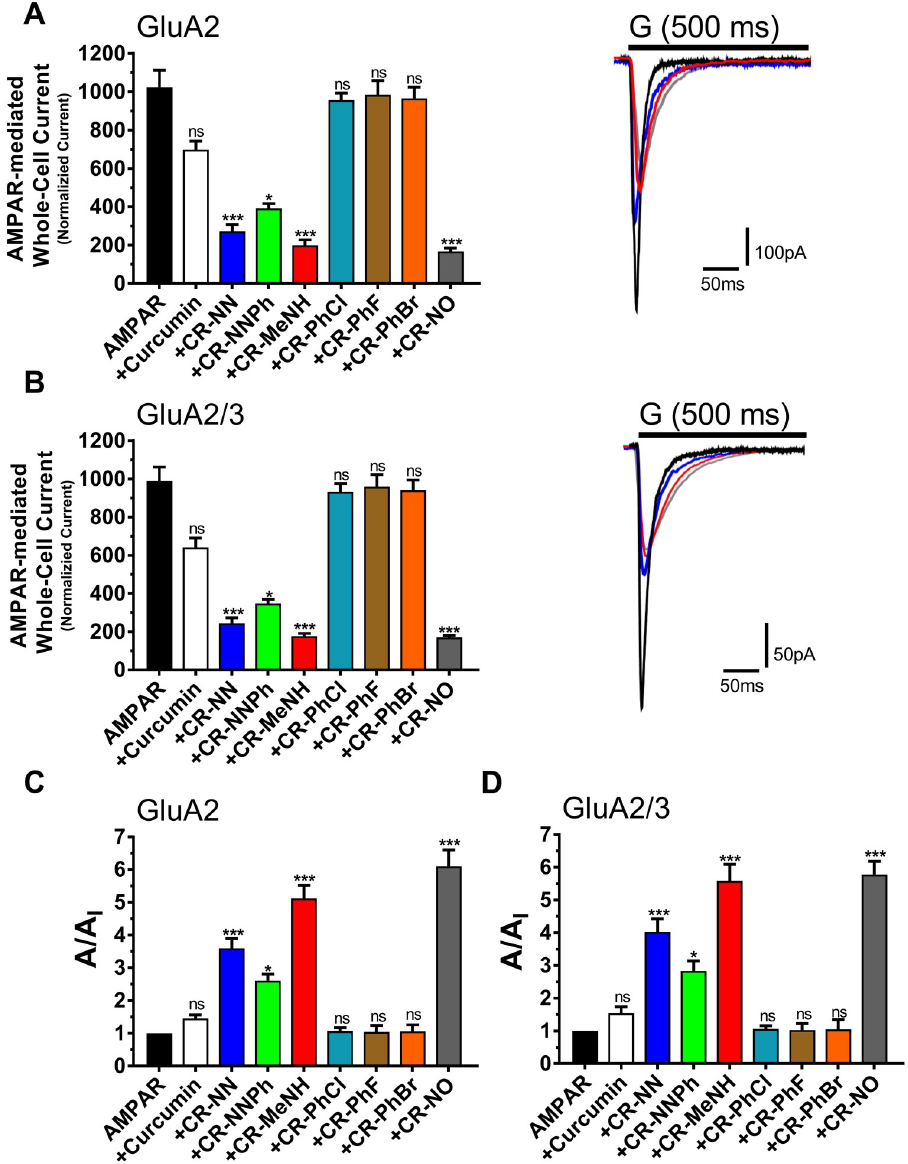
Fig 2. Effect of curcumin and the derivatives on the amplitude of the whole-cell current in the absence and presence of derivatives. A are the AMPAR recorded upon 500 ms application of 10 mM glutamate to whole-cell recording from HEK293 cells expressing homomeric GluA2 alone or in combination with the derivatives. B are the AMPAR recorded upon 500 ms application of 10 mM glutamate to whole-cell recording from HEK293 cells expressing heteromeric GluA2/3 alone or in combination with the derivatives. C - D Inhibition assays of different derivatives on GluA2 and GluA2/3. The whole-cell current recording was conducted at − 60 mV, pH 7.4, and 22 ˚C. Graphs summarize weighted time constants for activation. Data shown are mean ± SEM; n = 6 (number of patch cells in the whole-cell configuration). Significance (one-way ANOVA): � p < 0.05; �� p < 0.01; ��� p < 0.001; ns, not significant.